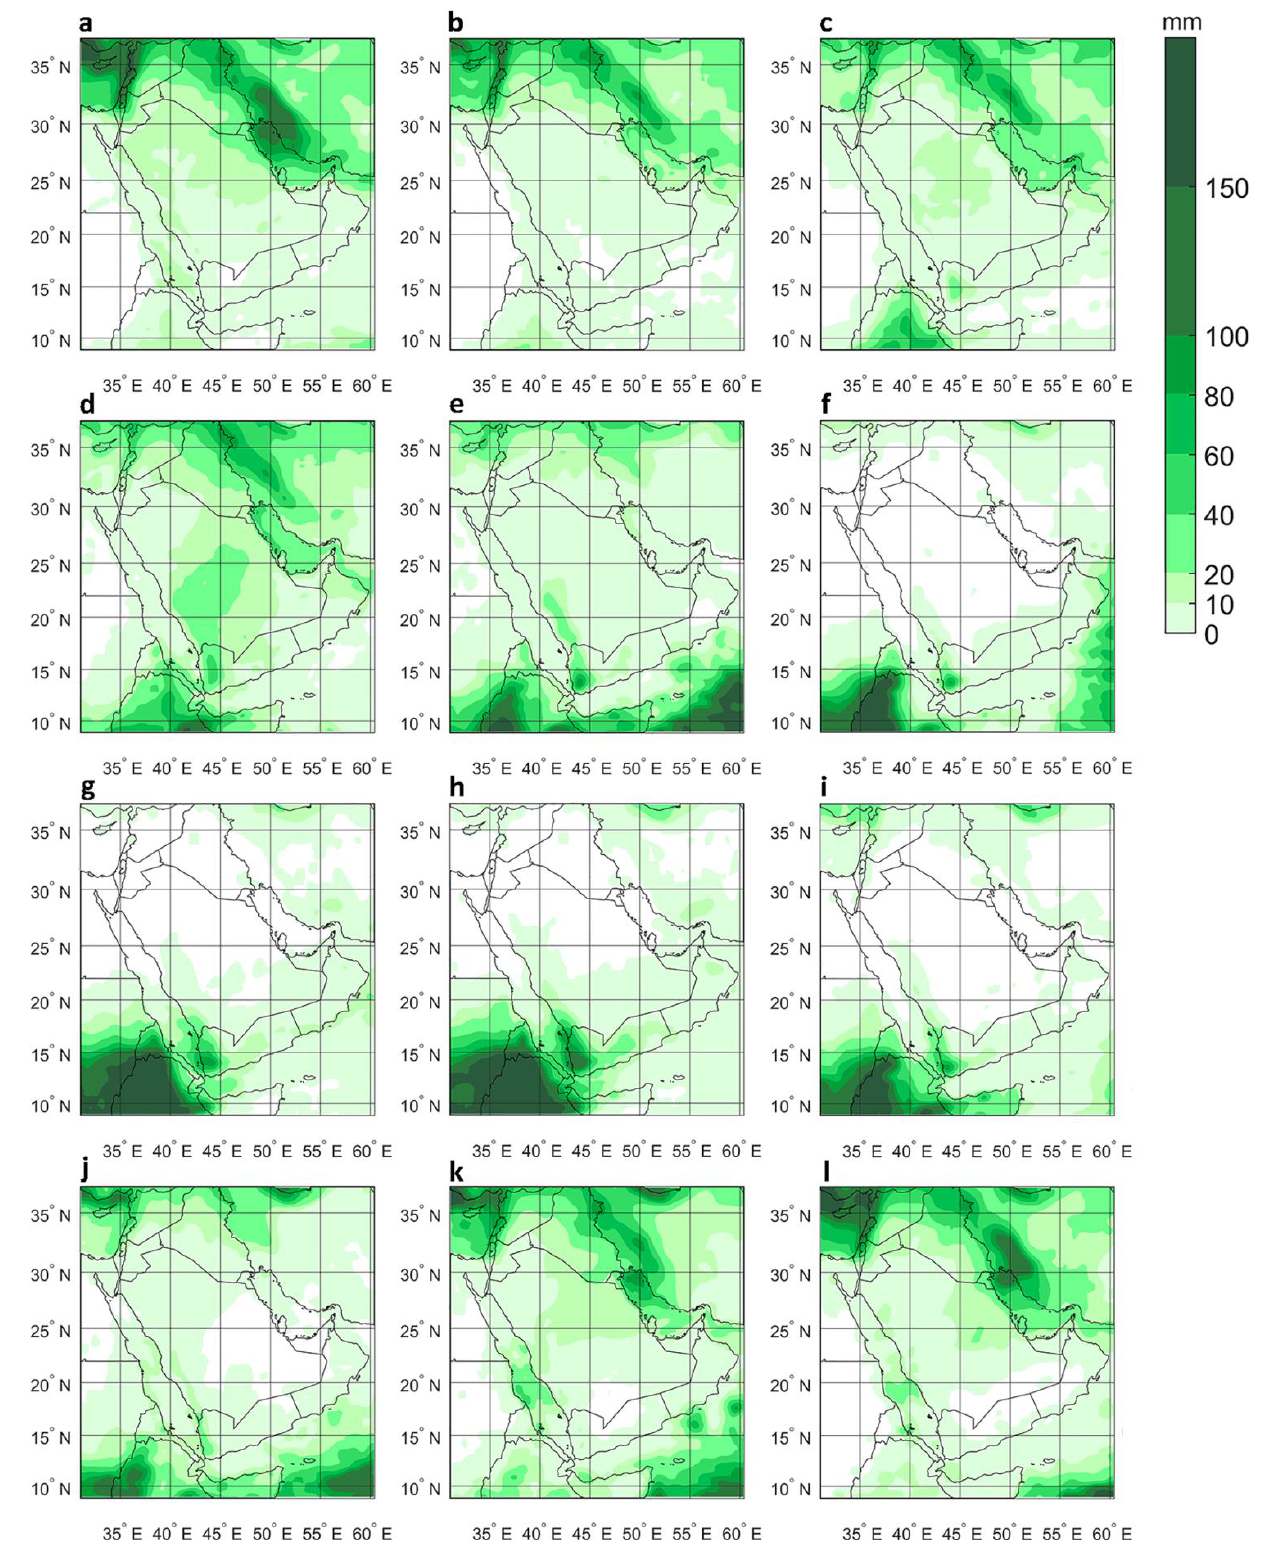
Figure A1. Mean monthly accumulated precipitation (IMERG) for ( a ) January, ( b ) February, ( c ) March, ( d ) April, ( e ) May, ( f ) June, ( g ) July, ( h ) August, ( i ) September, ( j ) October, ( k ) November and ( l ) December.